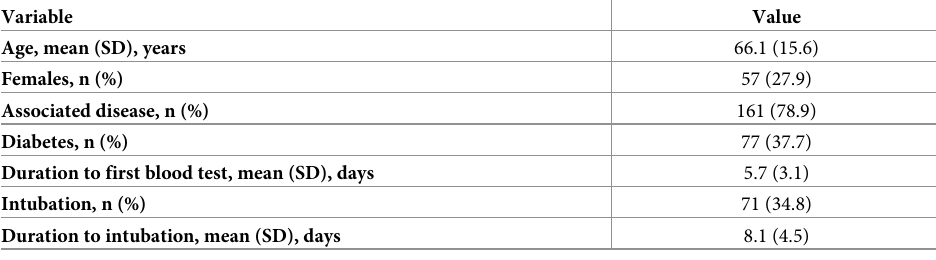
Table 1. Baseline characteristics of patients (n = 204).